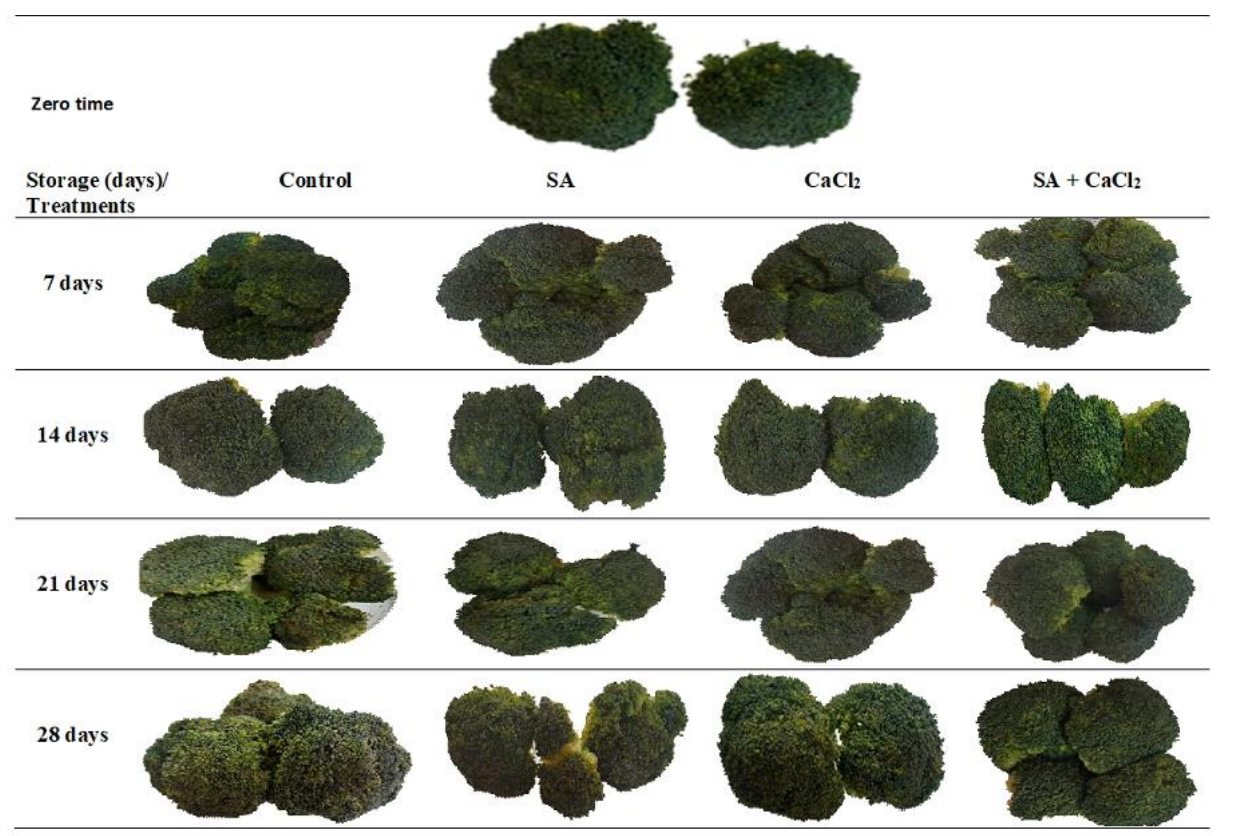
Figure 3. Effect of SA and CaCl 2 and their combination on the appearance and visual quality of broccoli florets stored at 5 °C for 28 days. broccoli florets stored at 5 ◦ C for 28